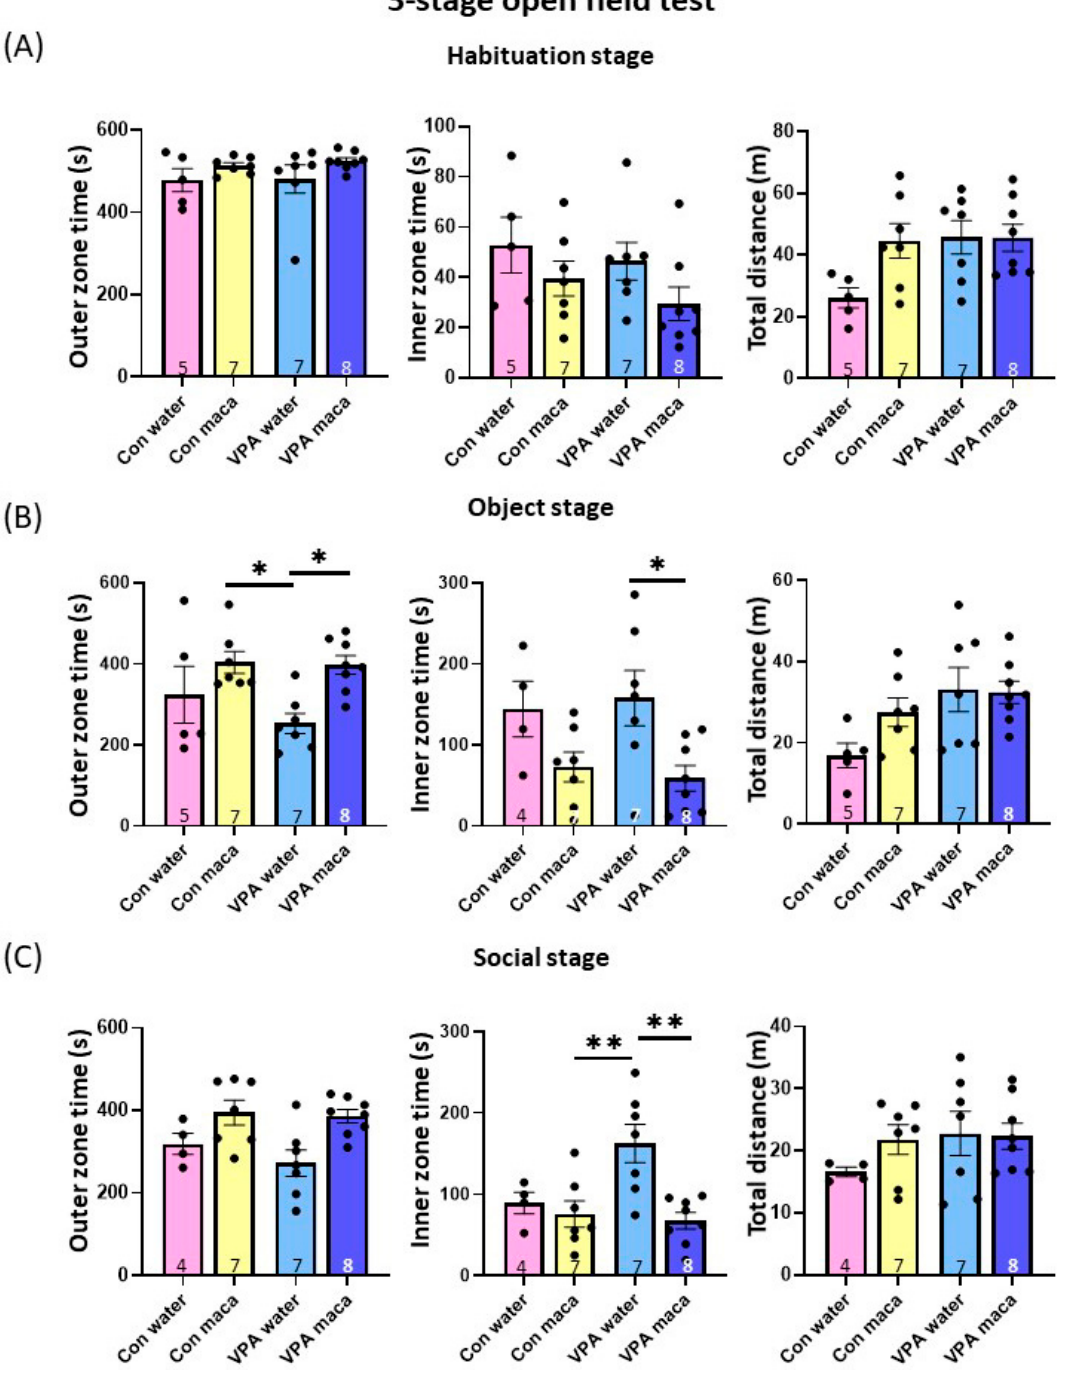
Figure 4. Maca recovered the social behavior deficit of VPA mice. The times in the outer zone and inner zone as well as the total distance were analyzed in the control and VPA groups gavaged with either water or maca ( A – C ). ( A ) Habituation stage. Behavior in the open field test with no object placed in the center. Times in the outer zone ( left ) and in center zone ( center ) as well as the total distance ( right ) were measured. ( B ) Object stage. Behavior in the open field with the object (food cage). ( C ) Social stage. Behavior in the open field with the male mice placed in the center. VPA mice spent more time in the center zone than the control mice. The number of mice used in each experiment is indicated in the graphs. Data are the mean ± SEM. * p < 0.05, ** p < 0.01. Con: control. VPA: valproic acid.